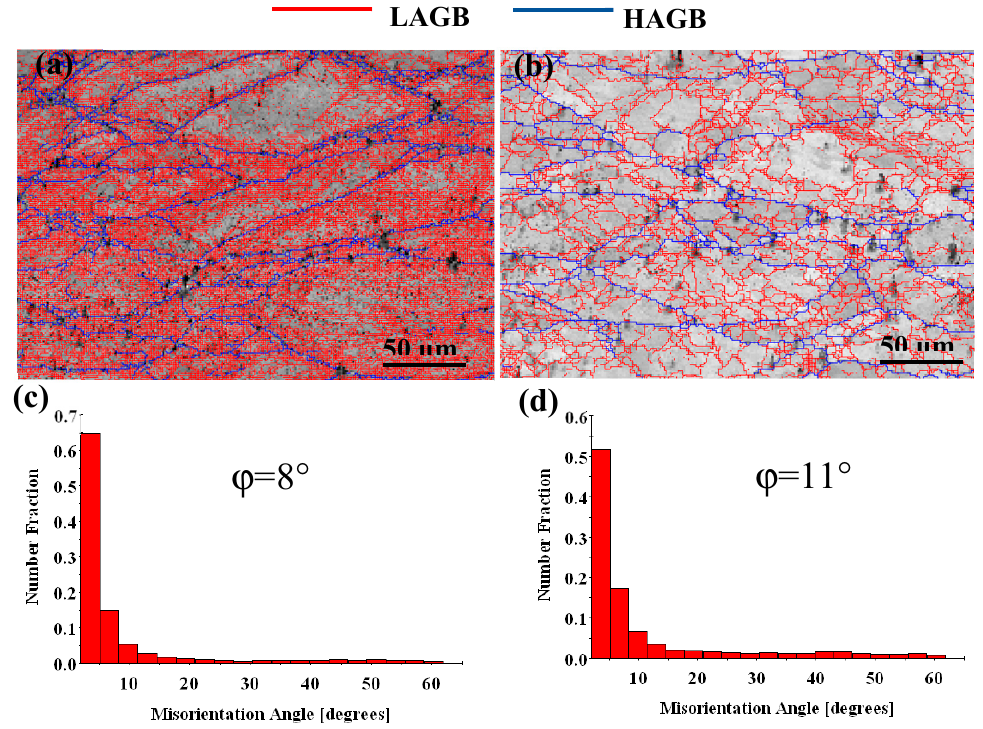
Figure 7. Orientation maps and misorientation angle distributions of the Cu-Ni-Co-Si-Cr-Ce alloy deformed at: ( a , c ) 600 ◦ C, 0.001 s − 1 ; ( b , d ) 900 ◦ C, 0.001 s − 1 . HAGBs are shown as blue lines, and LAGBs are shown as red lines. ϕ : The average misorientation angle.